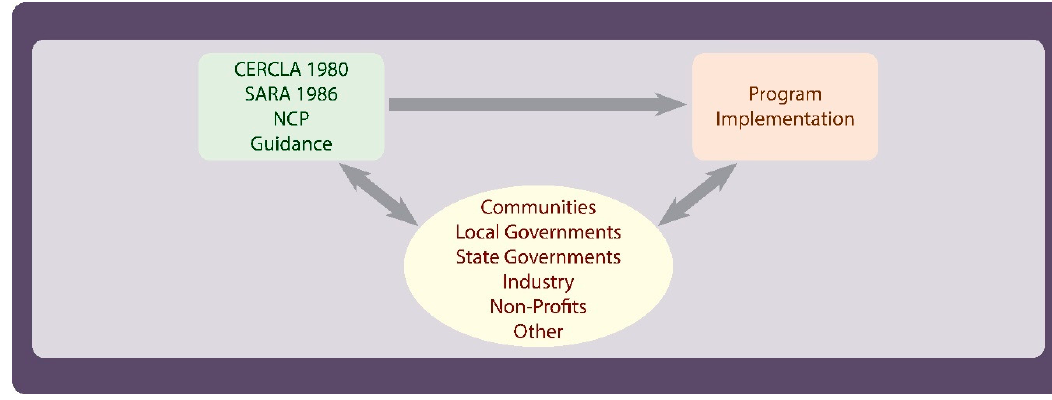
Figure 2. Program Policy, Implementation and Public Input.